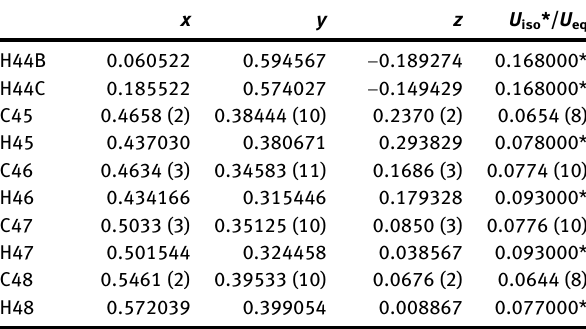
molecules of the title structure bond lengths and angles are very similar to those given in the literature for 3-hydroxynaphthalene-1,4-dione derivatives [12]. In the title structure, the parts of 3-hydroxynaphthalene- 1,4-dione of molecule A and B were approximately planar. The dihedral angles of molecule A formed by the C1 – C6 plane and the pyridine plane was 74.28(6) ° , while the dihedral angles of molecule B were 89.48(7) ° ,